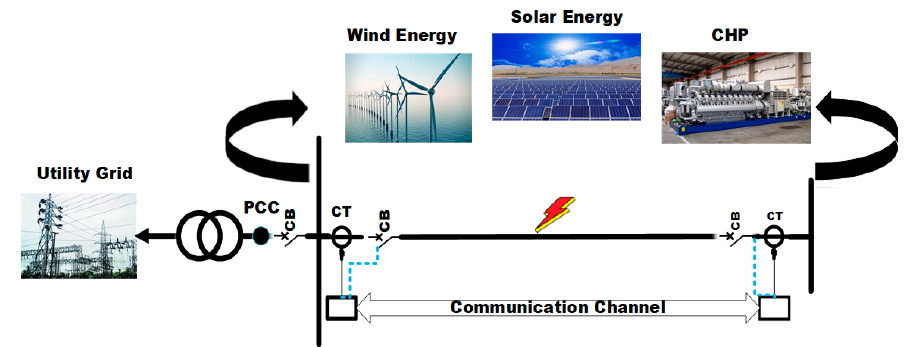
Figure 13. Differential-based protection scheme. Figure 13. Di ff erential-based protection